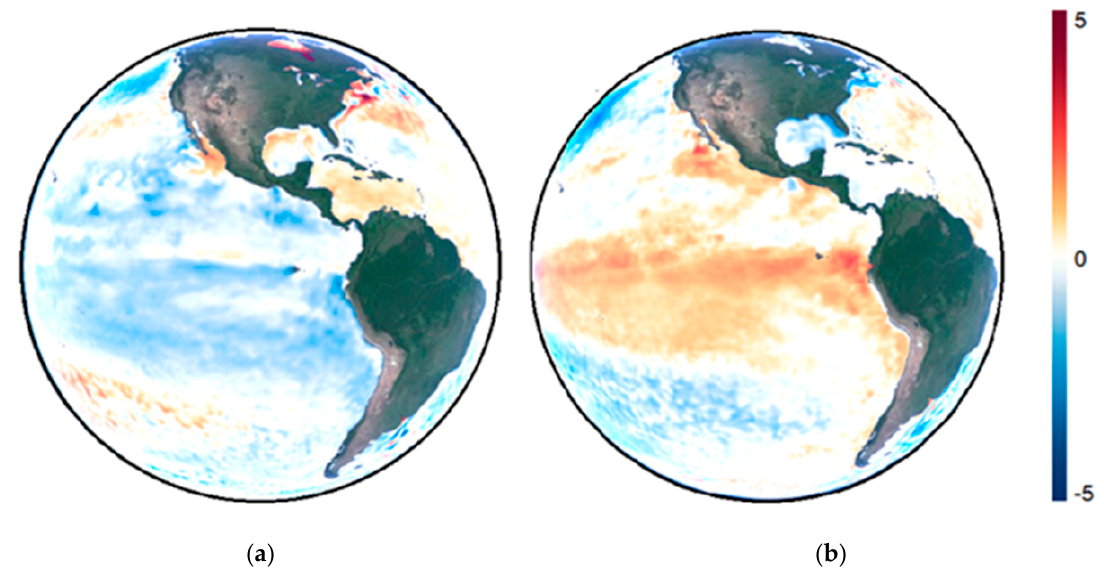
Figure 8. Sea surface temperature anomalies (°C) during: ( a ) October 2011–La Niña; ( b ) October 1987–El Niño. Data source: